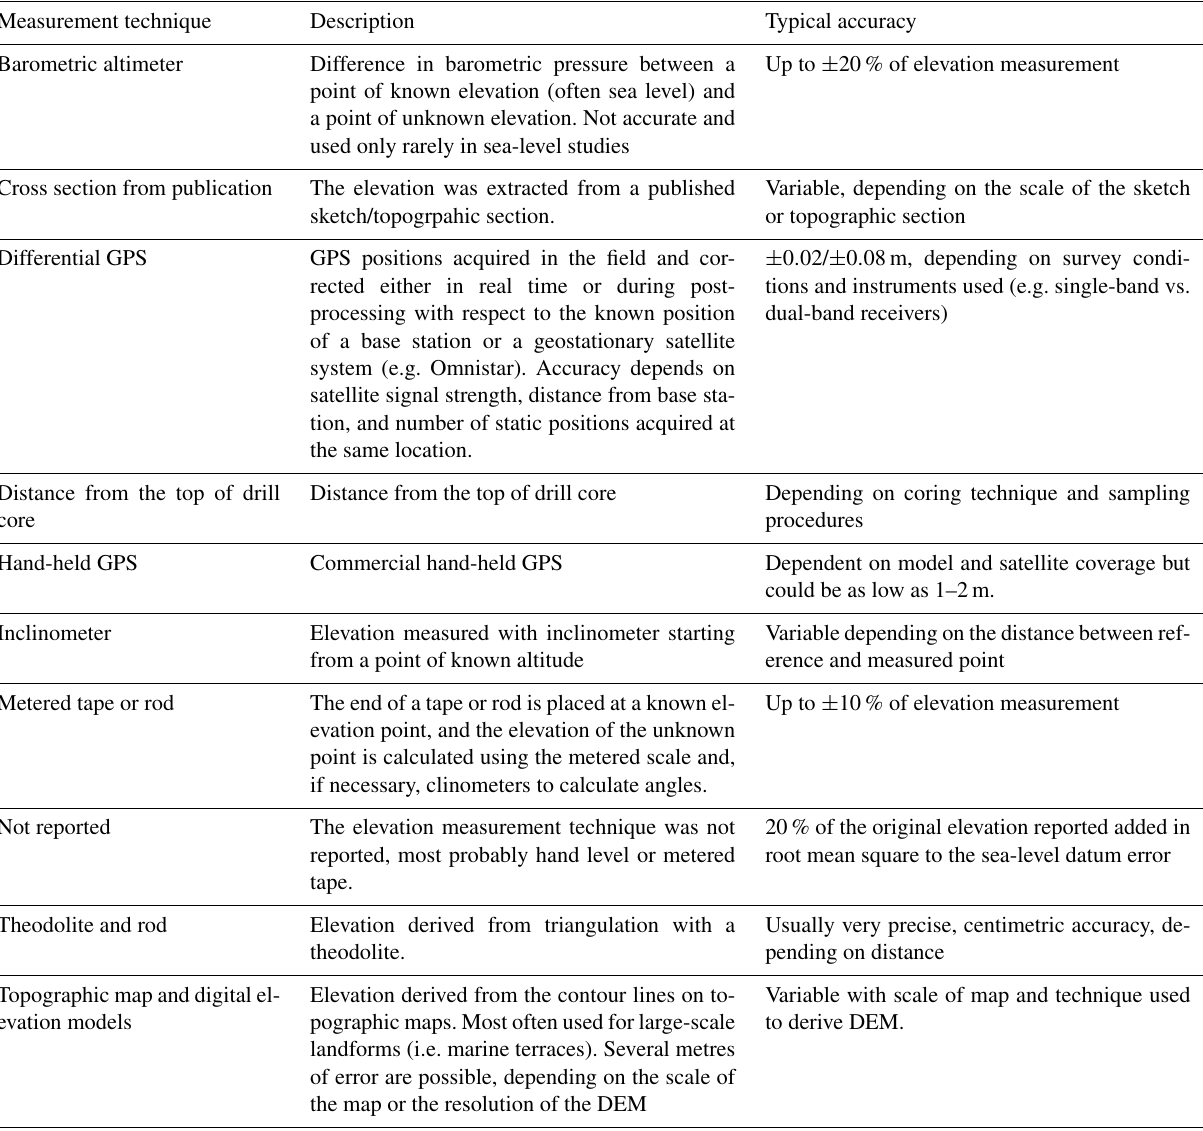
Table 1. Measurement techniques used to establish the elevation of LIG marine deposits (Rovere et al., 2020). GPS: Global Positioning System.